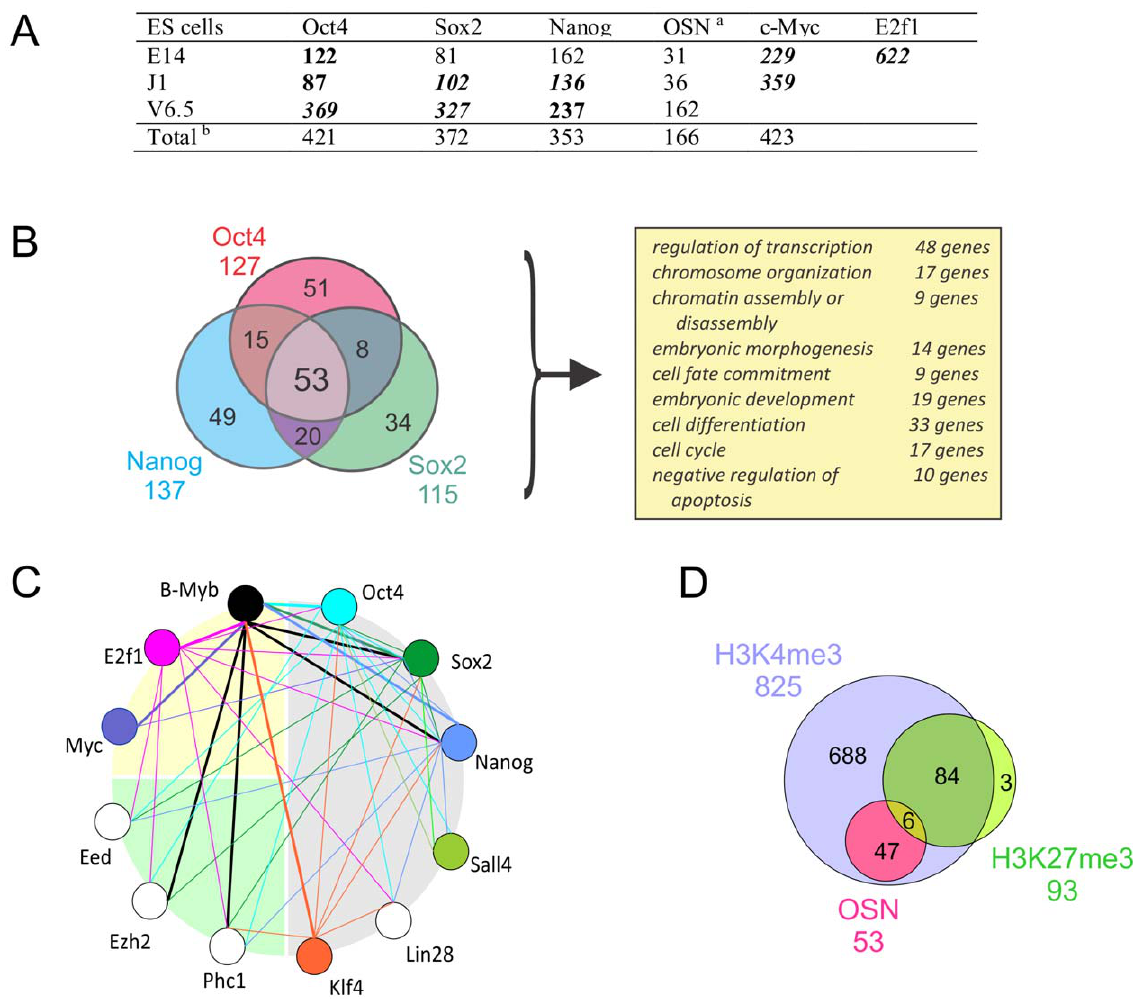
Figure 7. B-MYB target genes and possible interactions with pluripotency factors and regulation by histone methylation. A) Overlap of target genes between B-MYB and other selected TFs (see materials and Methods). Numbers in bold and italic refer to significant overlaps between two gene groups with p , 10 2 10 , in bold refers to p , 10 2 3 , respectively. B) Overlap of binding sites for Oct4, Sox2, Nanog (OSN) and B-MYB, and the corresponding biological process (GO terms) that were significantly elevated among the overlapping genes. C) Transcription factor binding interactome of selected genes associated with pluripotency, cell cycle and epigenetic regulation. Each gene is indicated by a circle, and lines connecting genes indicate TF binding. TF binding is directional, as the color of the line indicates which factor binds to the connected gene promoter. The data indicate a high level of crosstalk among pluripotency, cell cycle and epigenetic regulators with B-Myb. Data were taken from Table S1. D) Overlap among B-MYB target genes with OSN (common targets of Oct4, Sox2 and Nanog identified in at least two ES cells) and the state of histone methylation (H3K4me3, H3K27me3). All target genes used in this analysis were differentially repressed by the B-MYB knockdown based on the microarray